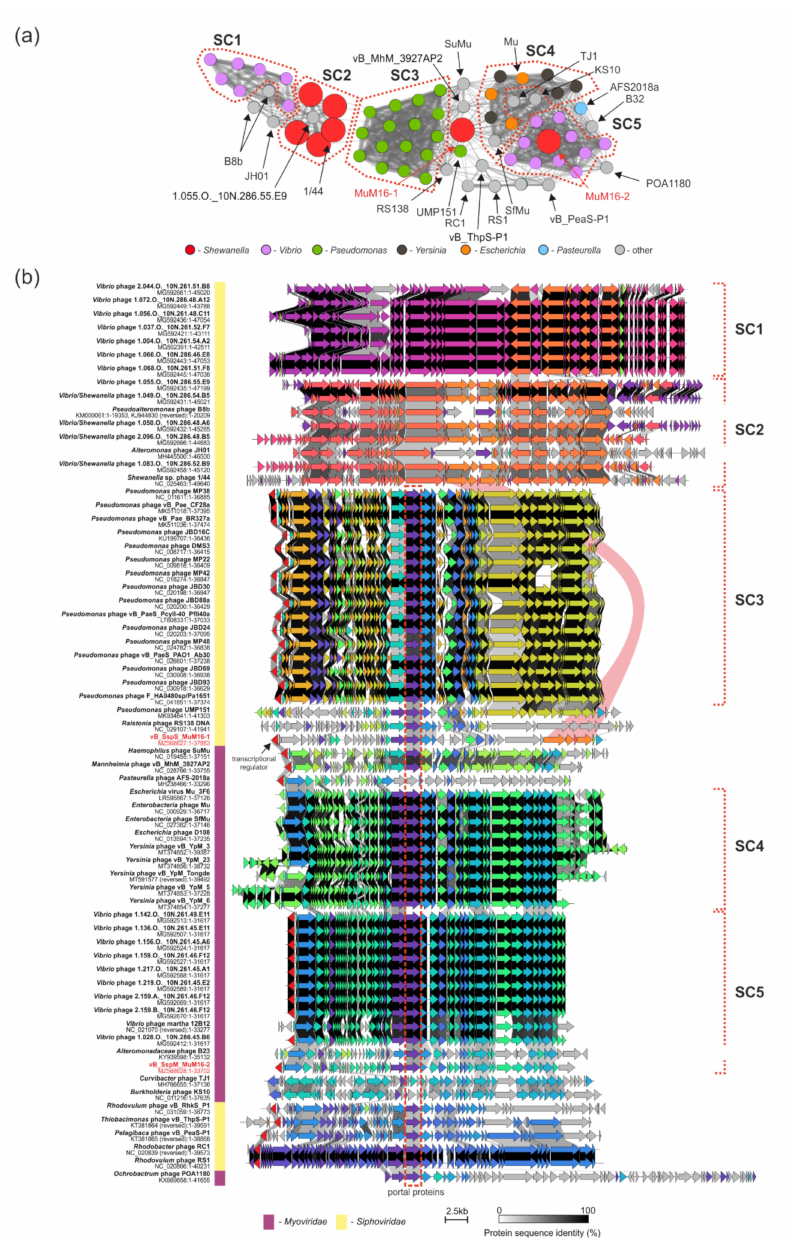
Figure 4. ( a ) Genomic comparison of the Mu-like phages’ similarity network neighborhood and ( b ) the alignment of these phage genomes. In ( a ), subclusters of phages grouped in the same viral clusters by vConTACT are marked with a dashed red line. Phage genomes in ( b ) are delineated